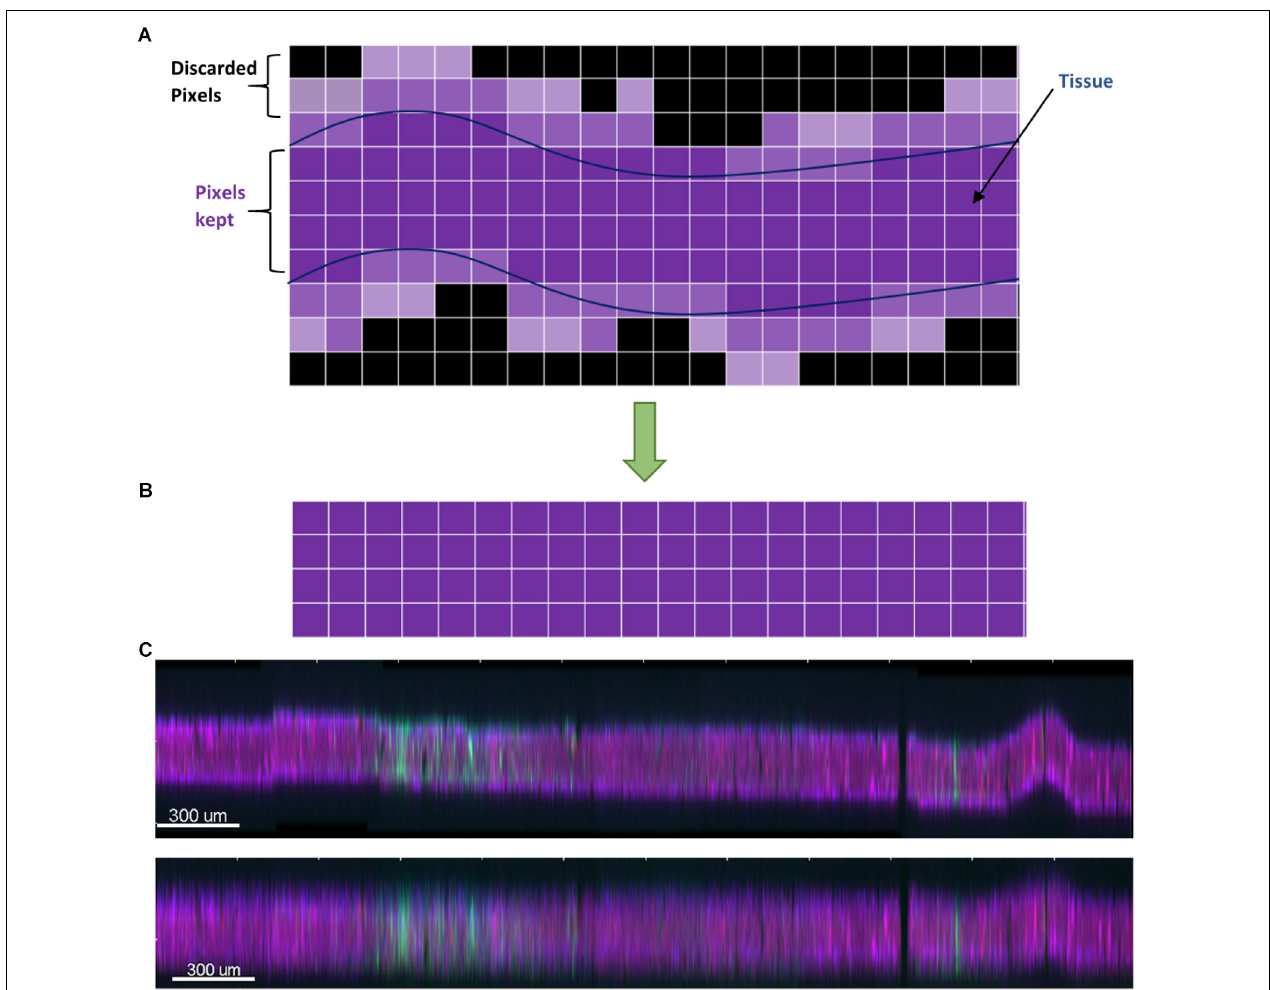
FIGURE 4 | (A) Schematic of the dewarping algorithm. The brightest contiguous subset of voxels in z is retained while the rest are discarded, resulting in a flatter section. (B) Vertical cross section through a section before dewarping with height scaled 10 × . The section is tilted, has a large wrinkle, and has a stitching artifact. (C) After dewarping the tissue is nearly flat (height still scaled 10 ×